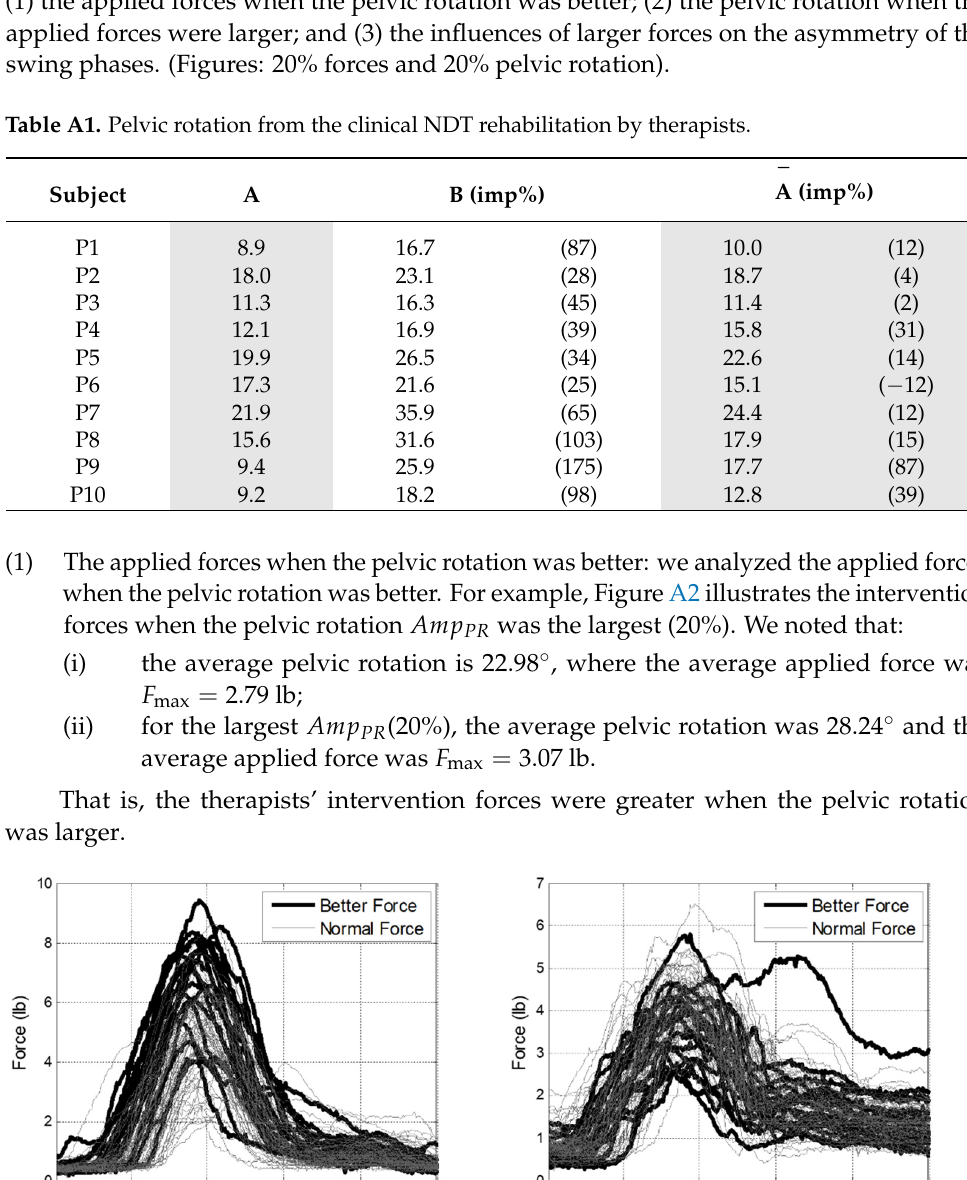
Table A1. Pelvic rotation from the clinical NDT rehabilitation by therapists.